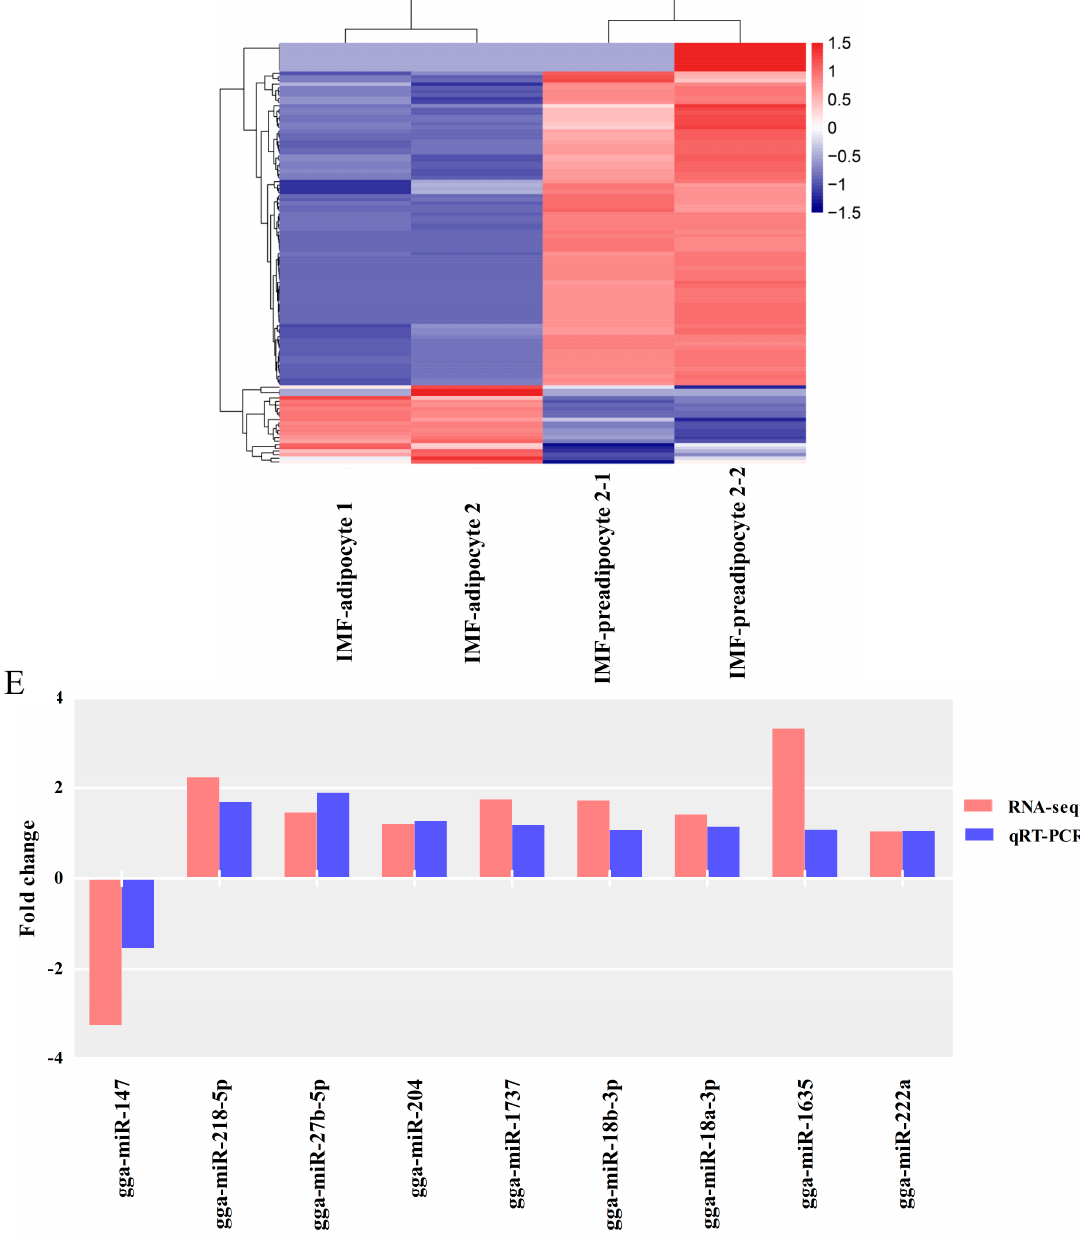
Figure 2. Small RNA sequencing and analysis of differentially expressed miRNAs. ( A ) Distribution of the length and abundance of small RNA sequences in chicken adipocytes. ( B ) Differential expression of miRNA in IMF-preadipocytes overlapping with that in IMF-adipocytes. ( C , D ) Volcano plot and heatmap of differentially expressed miRNAs between preadipocytes and adipocytes. ( E ) Verification of sequencing results by qPCR.